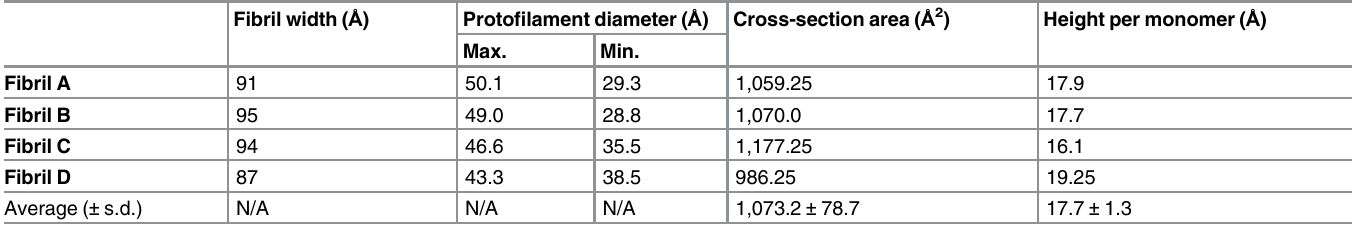
Table 1. Volumetric analysis of GPI-anchorless PrP 27 – 30 protofilaments. Fibril width ( Å ) Proto fi lament diameter ( Å ) Cross-section area ( Å 2 ) Height per monomer ( Å ) Max. Min. Fibril A